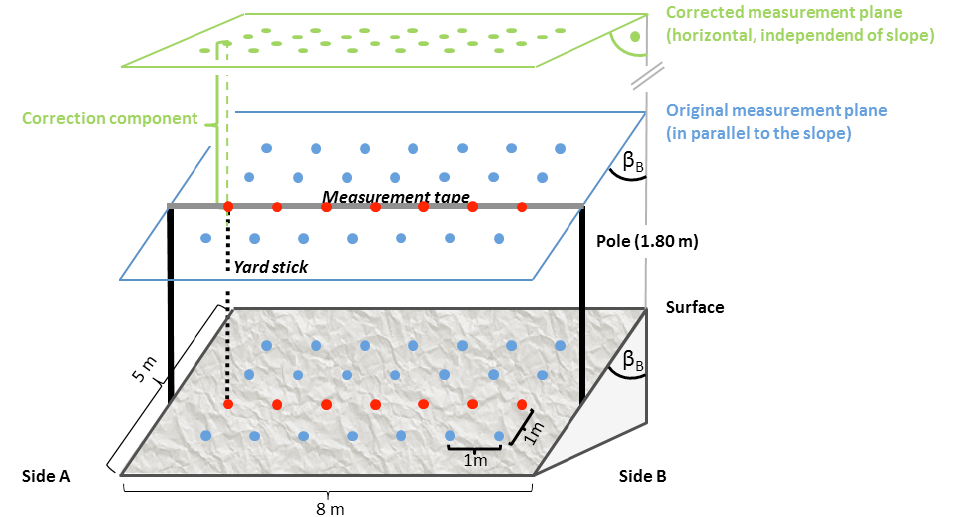
Figure 1. Within-plot sampling design: four transects of seven measurements each, resulting in 22 regular measurements (blue dots). Original sampling was performed from an imaginary plane 1.80 m above the plot and parallel to the slope. Values were corrected to equal those, which would have been obtained if they had been measured from a horizontal plane (green dots) . Red dots emphasize the measurements of one